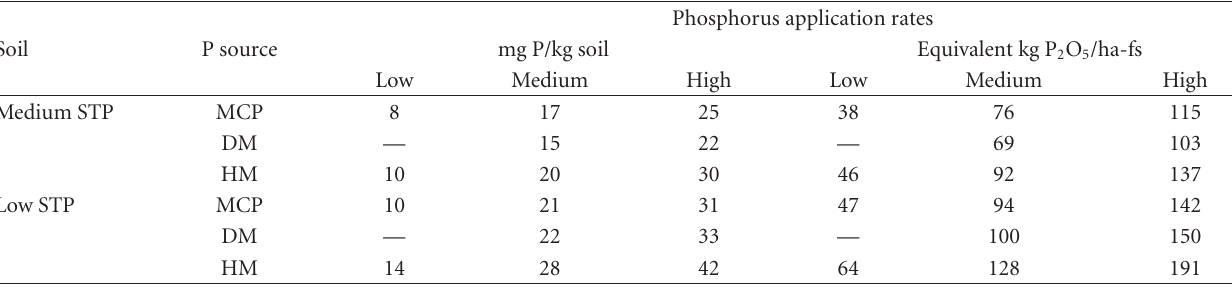
Table 3: Phosphorus application rates with low, medium, and high approximately equal to 1 / 2 × , 1 × , and 1 . 5 × the recommended P rate for spring feed barley, respectively.